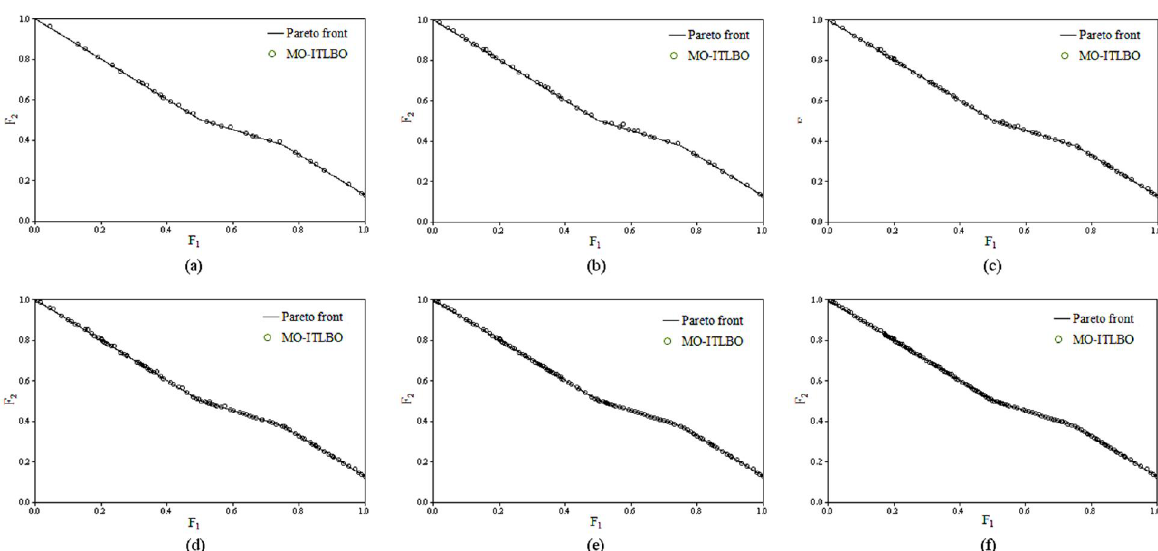
Fig. 6. Convergence of MO-ITLBO algorithm for the constrained test function CF4 (a) 50000 FE (b) 100000 FE (c) 150000 FE (d) 200000 FE (e) 250000 FE and (f) 300000